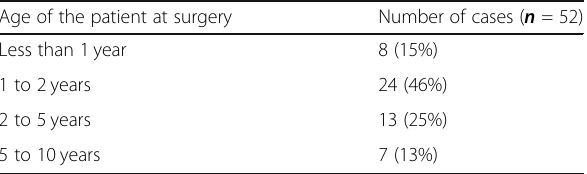
Table 3 Assessment of procedure required for urethroplasty: variation between preoperative and intraoperative assessment